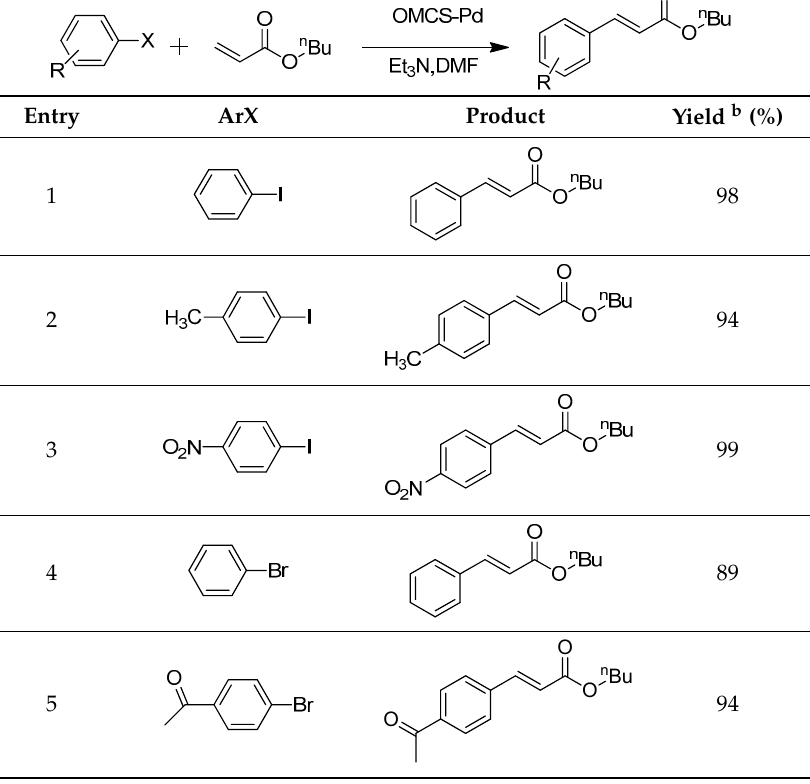
Table 1. Heck reaction of aryl halides and n -butyl acrylate catalyzed by OCMCS-Pd a .